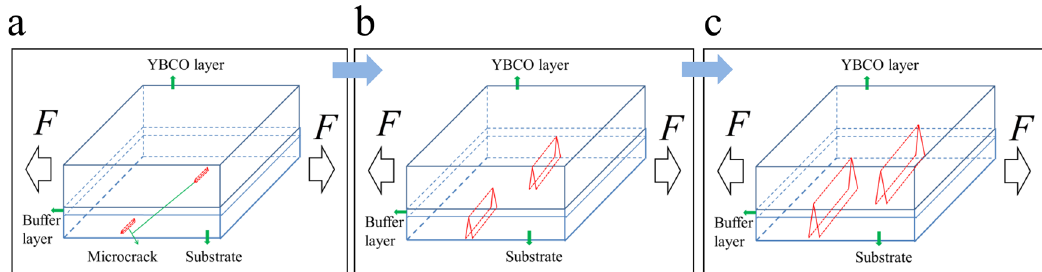
Fig. 10 Schematic of damage formation process during tensile strain. a Micro cracks in a cleavage-type started from the substrate. b Micro cracks propagate into the buffer layer with an increasing strain. c Microcracks penetrate into the superconducting layer along the directions of both the thickness and width when the strain